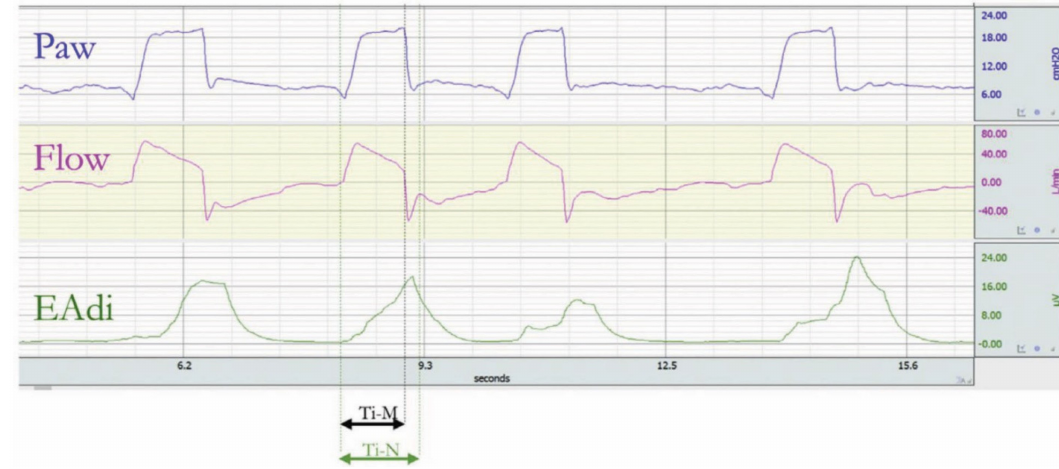
Figure 4. Example of premature cycling in pressure support ventilation. The patient’s neural inspiration time (Ti-N), which is from triggering to the moment the electrical activity of the diaphragm (EAdi) drops to 70% of its maximal value, is longer than the breath delivered by the ventilator (Ti-M). Reprinted with permission from